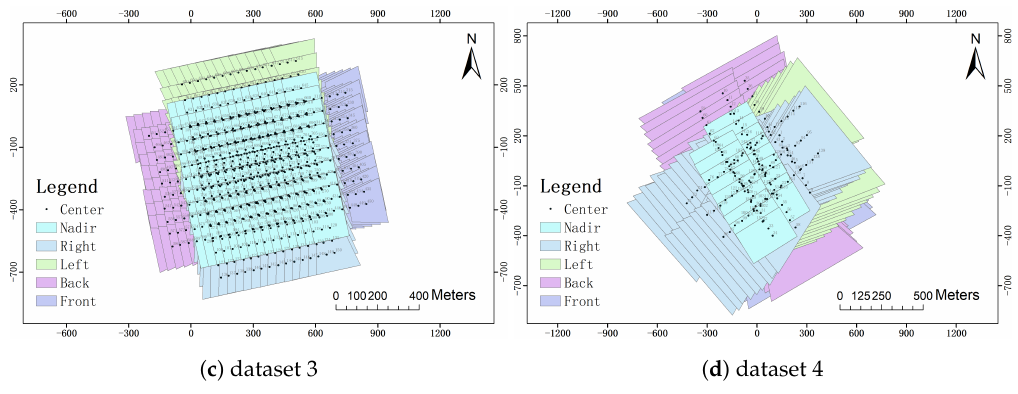
Figure 6. Image footprints of the four datasets